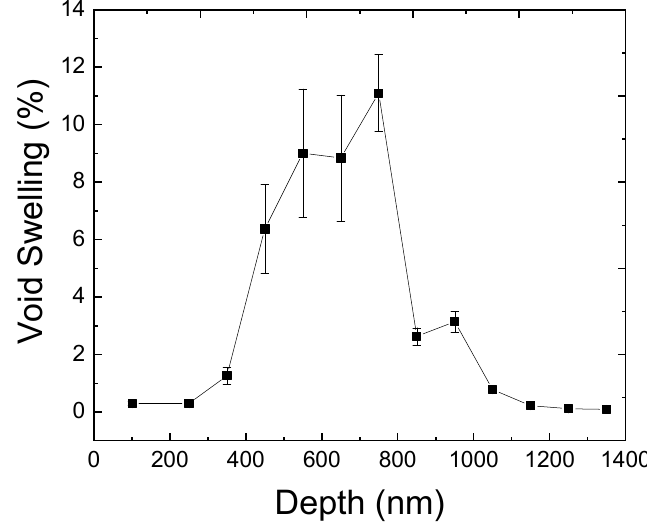
Figure 4. Void size and density as a function of depth in the specimen containing a trench starting at about ~1.7 µ m beneath the surface.